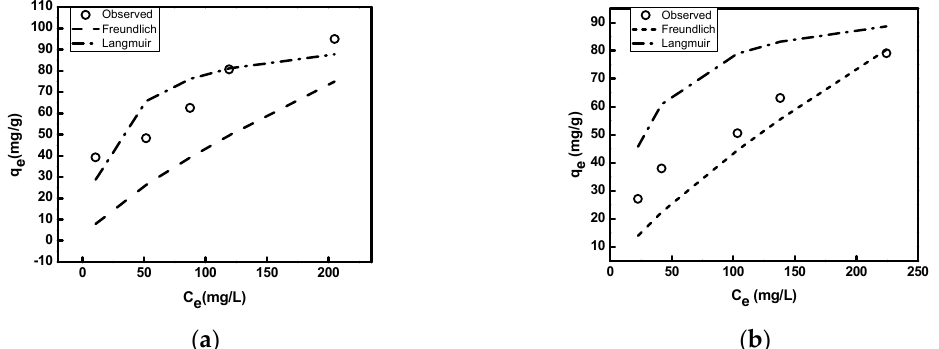
Figure 8. Nonlinear Freundlich and Langmuir isotherms for 2,4-D adsorption onto ( a ) AC and ( b ) MAC at 25 °C.